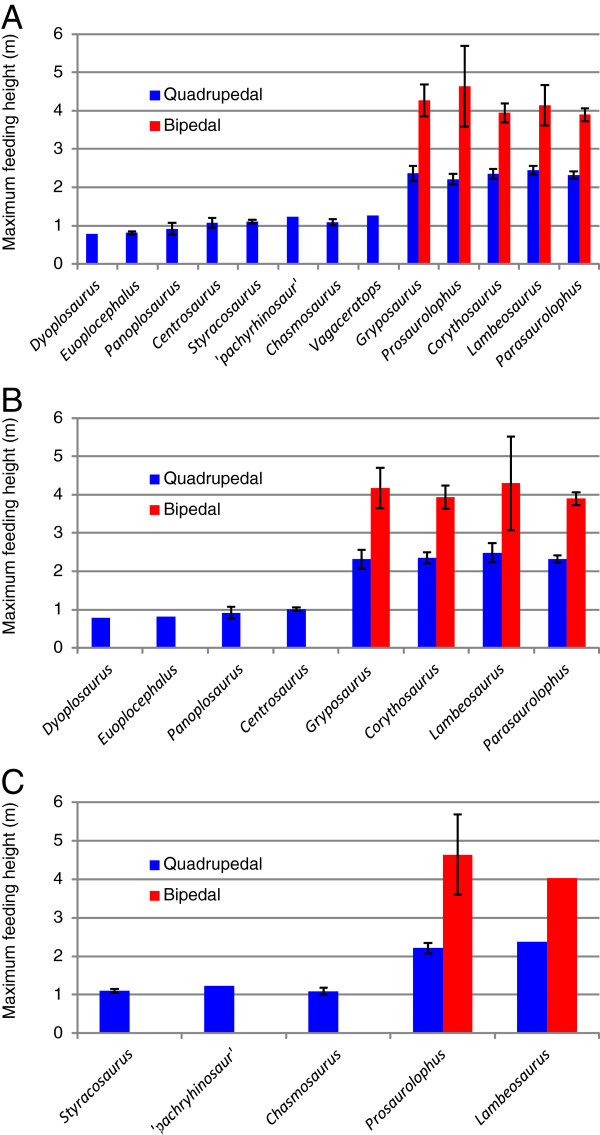
Reconstructed MFHs of the herbivorous dinosaurs from the DPF. A, time-averaged analysis; B, MAZ-1 analysis; C, MAZ-2 analysis. Scale bars represent 95% confidence intervals.